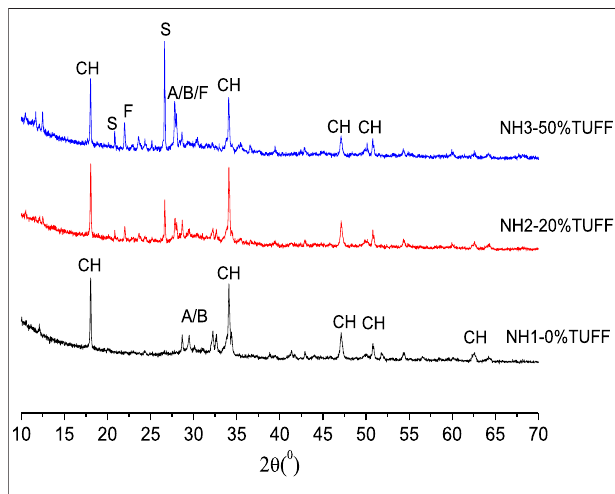
FIGURE 8 | The XRD patterns oftuff powder-cement hardened paste at the hydration age of 180 days.